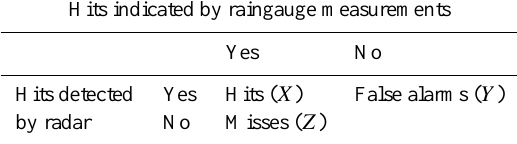
Table 2. Contingency